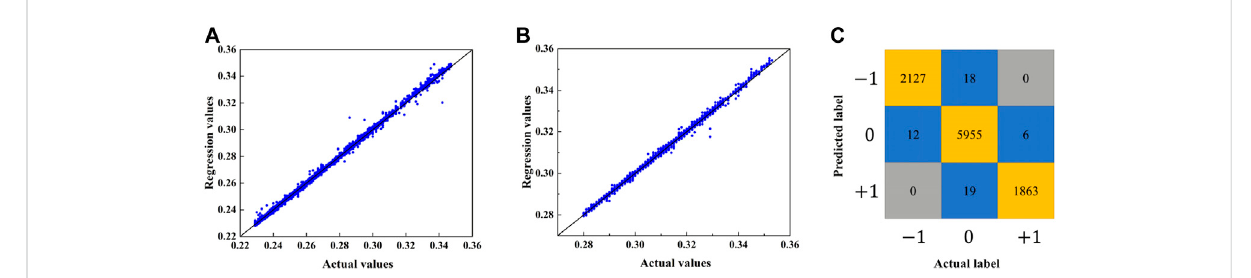
FIGURE 6 Comparisons between the predicted and actual values of (A) the lower bounds, and (B) the upper bounds of the normalized objective bandgap. (C) Confusion matrix of the test set of the classi fi cation neural network.